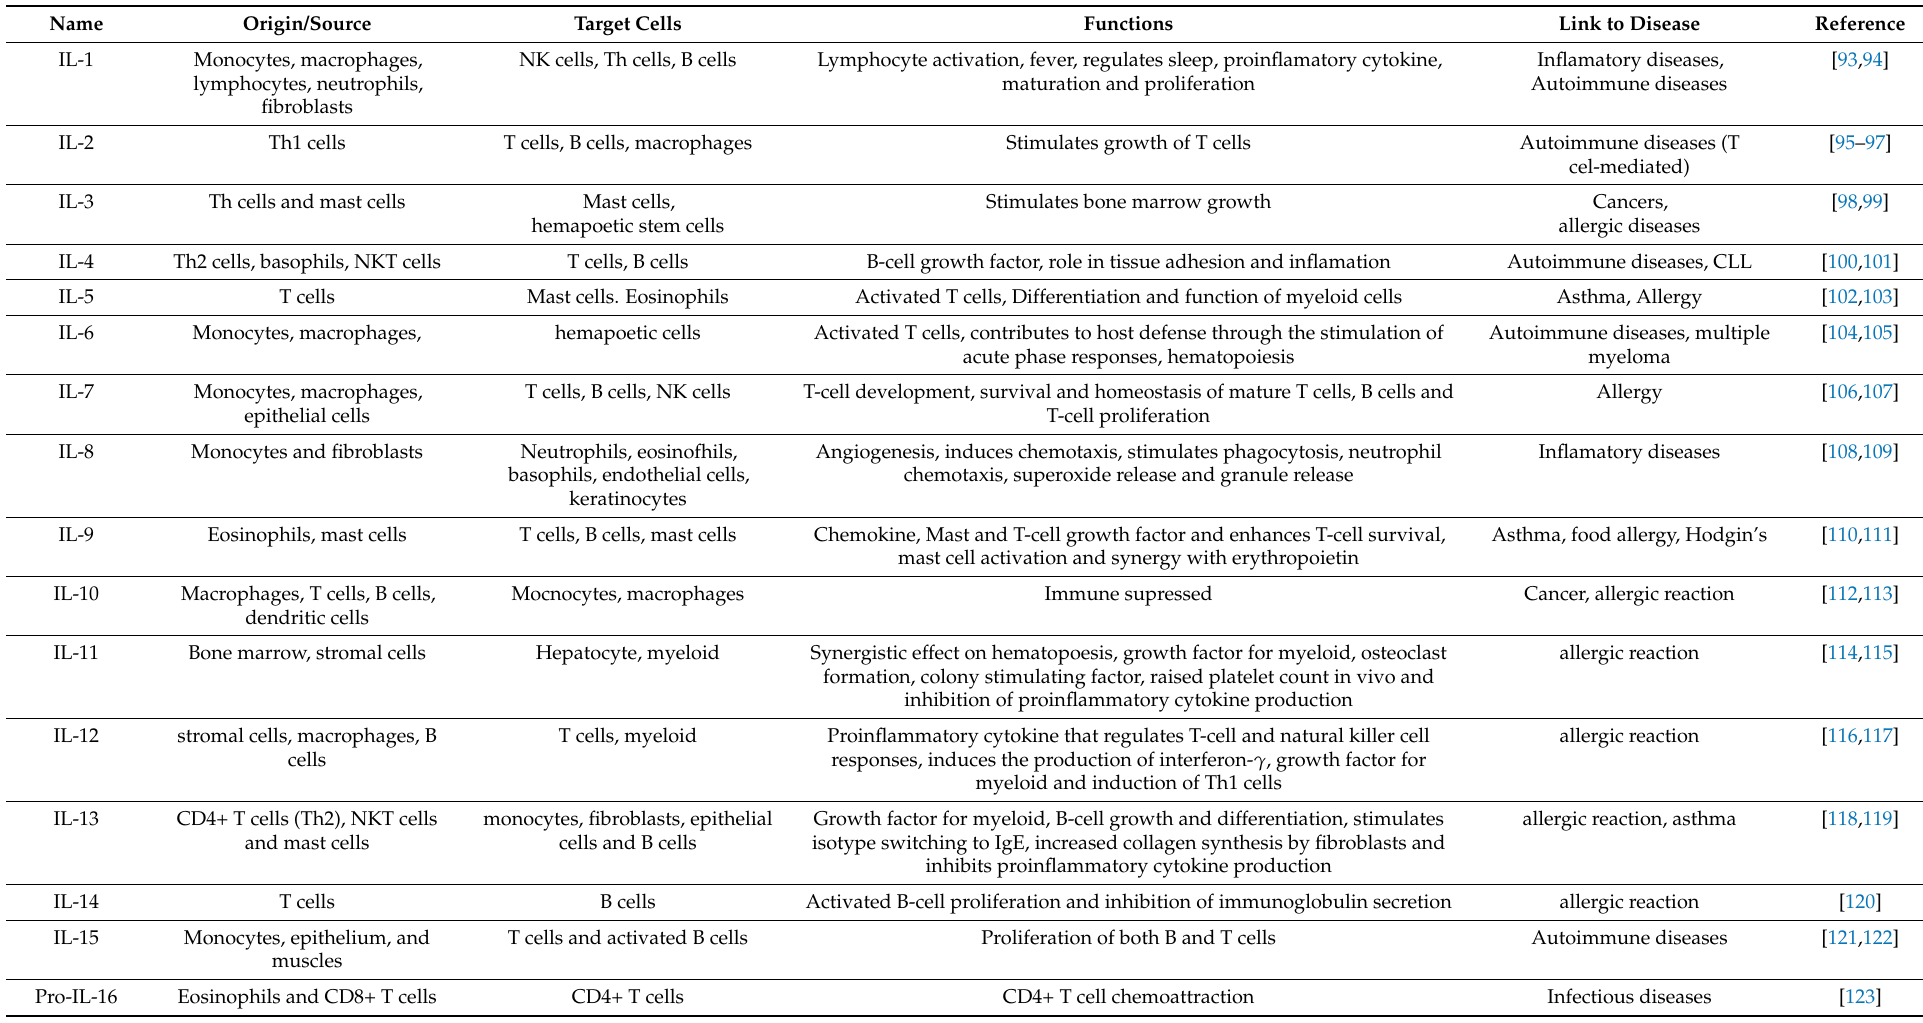
Table 3. Origin and functions of human